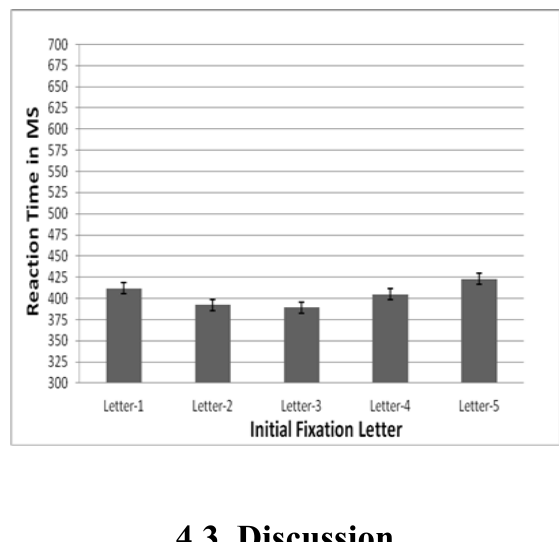
Figure 5. Reaction time for five-letter words as a function of the initial fixation letter (first, second, third, fourth, and fifth). Note: Error bars represent stan - dard error